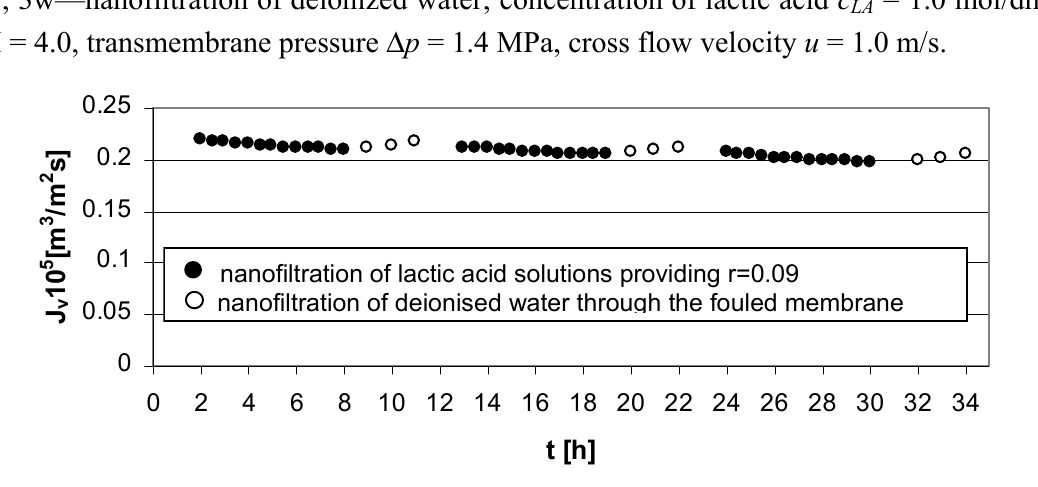
= 1.0 mol/dm 3 , LA